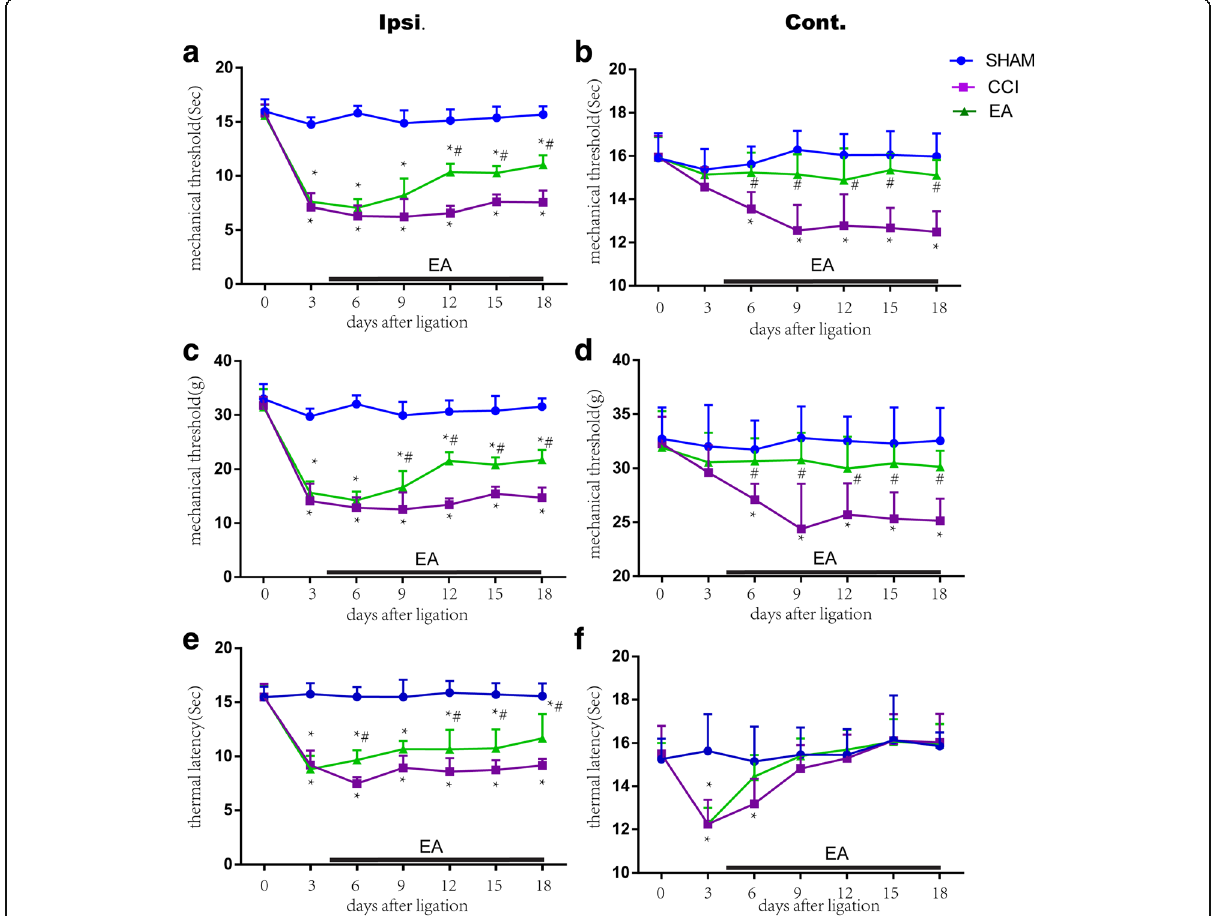
Fig. 1 Repeated EA treatment reduced CCI-induced mechanical and thermal hyperalgesia and mirror-image pain in neuropathic pain rats (mean±SD, n =12/group). Both mechanical (response time: a , force threshold: b ) and thermal paw withdrawal latencies (PWLs) at the ipsilateral (Ipsi., a, c, e ) and contralateral (Cont., b, d, f ) paws were observed before and every 3 days after chronic constrictive injury (CCI) of the sciatic nerve. Compared with the CCI rats, CCI-decreased mechanical PWLs were significantly increased by EA treatment from the 12th day on (time response: a ) and 9th day on (force response: c ) after surgery on the Ipsi. side ( a, c ), and from the 6th day on the Cont. side ( b, d ); and CCI-decreased thermal PWLs were significantly up-regulated by EA from the 6th day on after surgery on the Ipsi. side ( e ) and turned to the normal level from the 6th day on after surgery on the Cont. side ( f ), suggesting a positive effect of EA on chronic neuropathic pain and mirror-image pain. (* P <0.05, vs the sham group; # P <0.05, vs the CCI